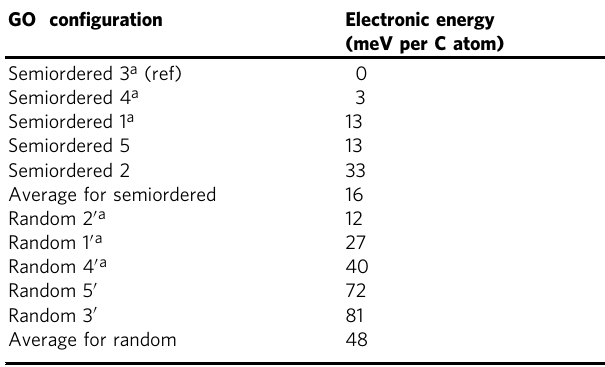
All structures are relaxed using the CP2K code (see “ Methods ” ). a The three most stable structures of each GO type that are further studied in this paper and displayed in Fig. 1.